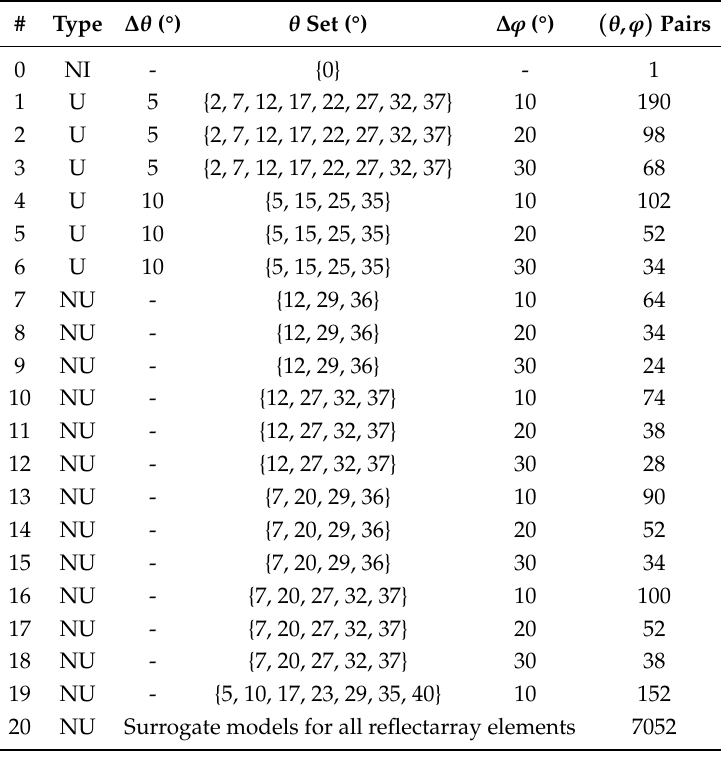
Table 2. Data regarding the discretization of the angles of incidence. Type refers to the discretization of θ (N, normal incidence; U, uniform; NU, non-uniform).